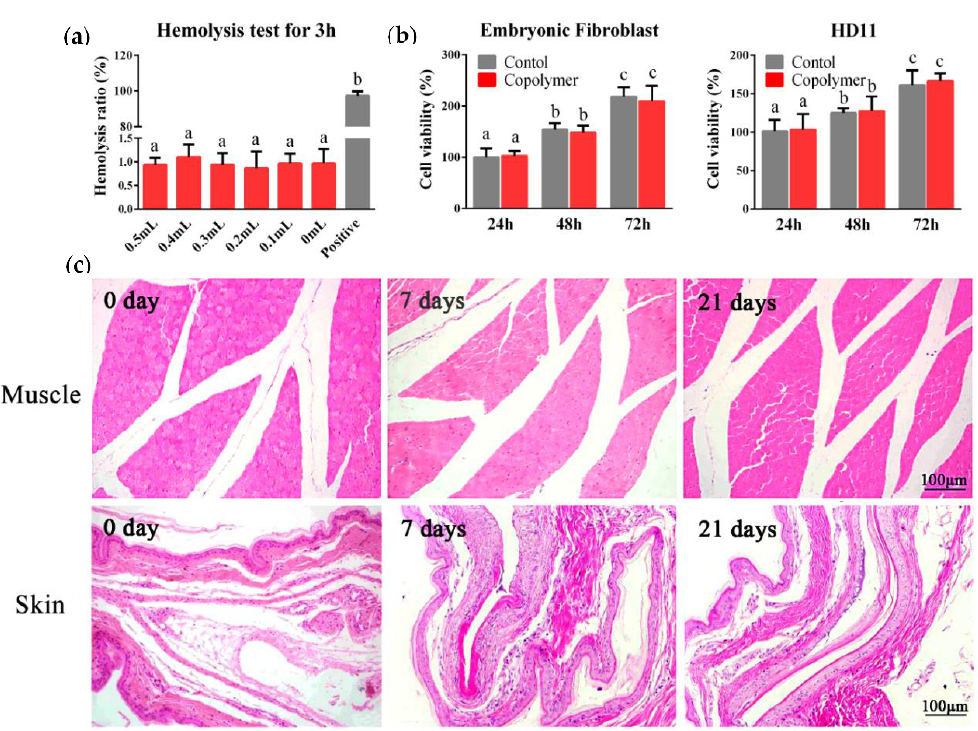
Figure 2. Safety of the PLGA-PEG-PLGA hydrogel. ( a ) The blood compatibility of the material was studied by a hemolysis test. We cultured the chicken blood with 0.5, 0.4, 0.3, 0.2, 0.1, and 0 mL polymer solution (original concentration was 20%) for 3 h, and distilled water was chosen for the positive control to induce hemolysis. ( b ) The cytotoxic test results in the chicken embryonic fibroblast and HD11. ( c ) After intramuscular or subcutaneous injection, the muscle and skin from the injection site were collected for the hematoxylin-eosin (HE) staining to observe the inflammatory cell infiltration. The results are expressed as the mean ± SD of three independent experiments. Bars with different superscripts mean significant differences ( p < 0.05).